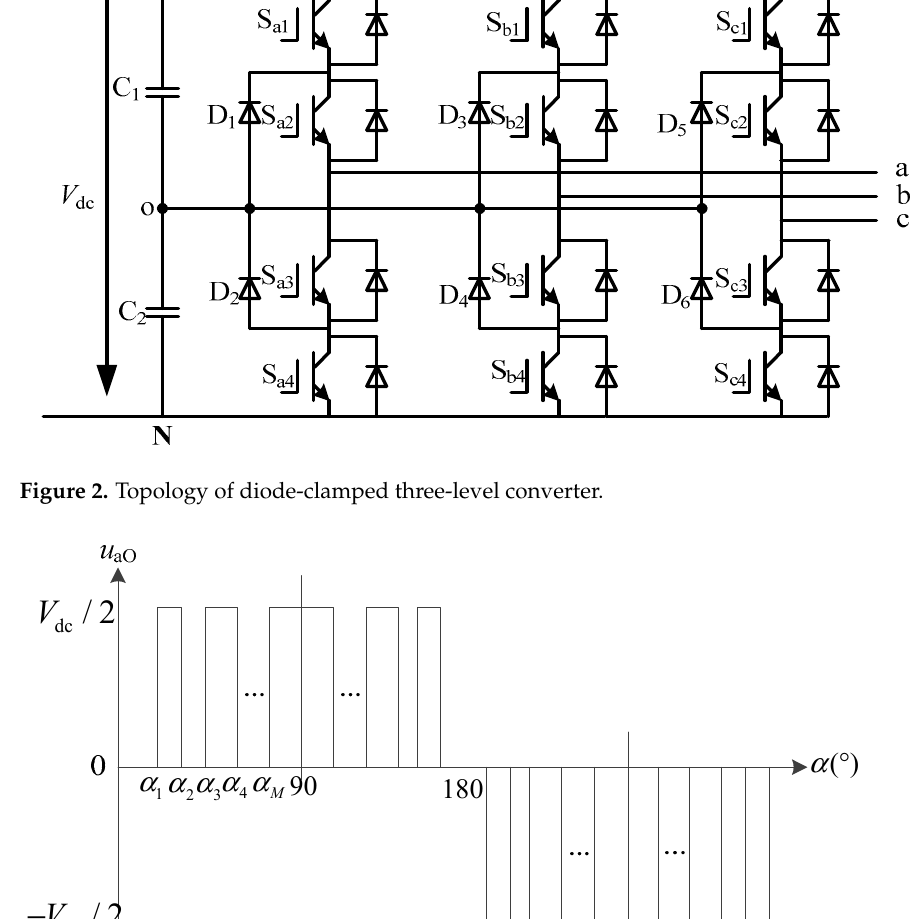
Figure 1. Complex matrix model of an electrically excited motor.